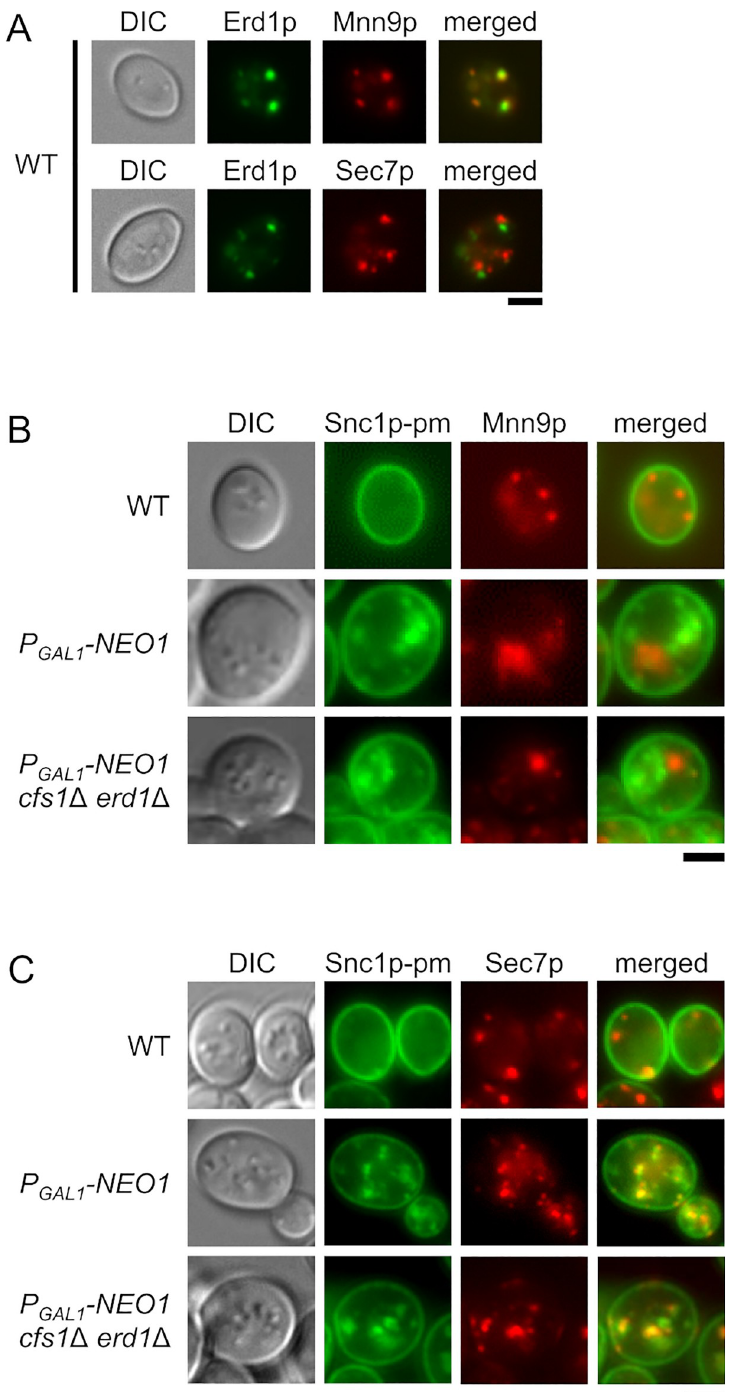
Fig 2. Localization of GFP-Snc1p-pm in the Neo1p-depleted cfs1 Δ erd1 Δ mutant. (A) Colocalization of Erd1p-GFP with Mnn9p-mRFP1. Cells were cultured in YPGA at 30˚C for 7 h, followed by microscopic observation. The strains used were P GAL1 - ERD1 - GFP MNN9 - mRFP1 (YKT2150) and P GAL1 - ERD1 - GFP SEC7 - mRFP1 (YKT2151). (B) Localization of GFP-Snc1p-pm and Mnn9p-mCherry in the Neo1p-depleted cfs1 Δ erd1 Δ mutant. Cells were cultured in YPDA at 30˚C as in Fig 1C. The strains used were wild type (WT) (YKT2152), P GAL1 - NEO1 (YKT2153), and P GAL1 - NEO1 cfs1 Δ erd1 Δ (YKT2154), all of which carry GFP - SNC1 - pm and MNN9 - mCherry . (C) Localization of GFP-Snc1p- pm and Sec7p-mRFP1 in the Neo1p-depleted cfs1 Δ erd1 Δ mutant. Cells were cultured in YPDA at 30˚C as in Fig 1C.